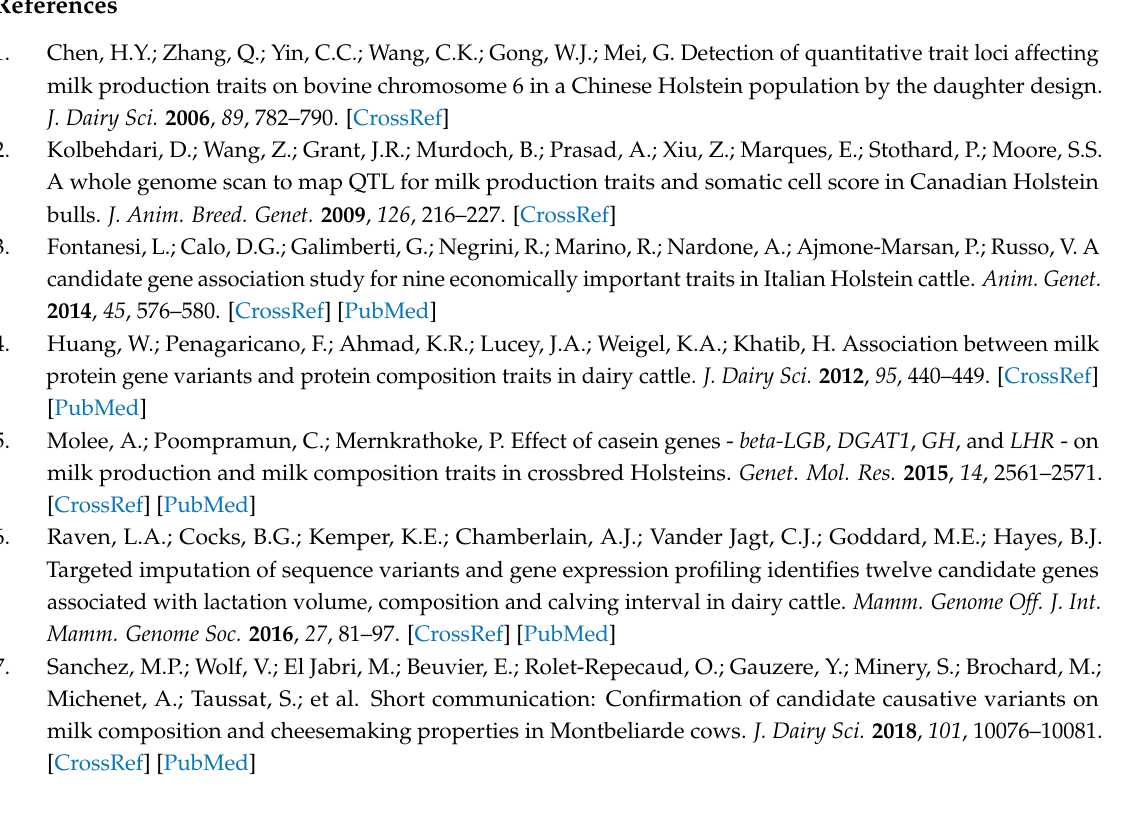
Table S1: The distribution of daughters from 17 herds in 17 farms. Table S2: PCR primers information of HSPA8 and ERBB2 genes. Table S3: Additive, dominant and allele substitution effects of the SNPs associated with milk production traits of HSPA8 and ERBB2 in Chinese Holstein cattle. Table S4: The predicted miRNAs targeted to the 3 (cid:48) -UTR of HSPA8